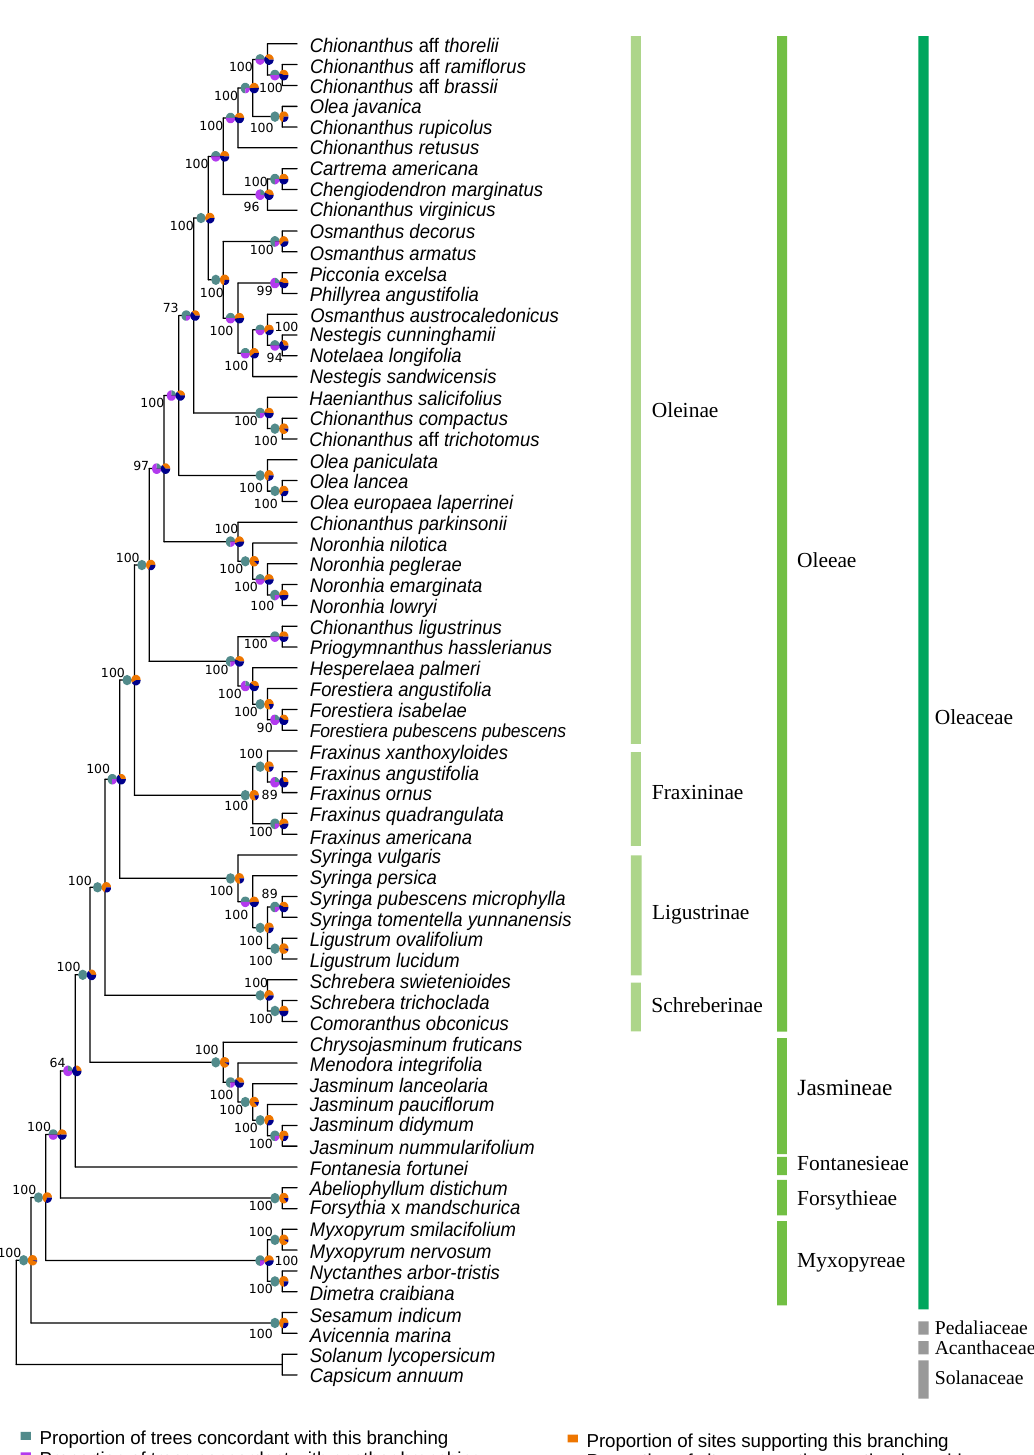
Figure 6. Maximum likelihood topology of Oleaceae family estimated from the partitioned concatenation of 80 plastid coding sequence, 37 mitochondrial genes, the complete nuclear ribosomal DNA cluster and three nuclear genes encoding phytochromes ( phyE-1, phyB-1a, phyB-1b ). Concordance factors were calculated in relation to the species trees inferred for each partitioned dataset. Gene concordance factors are represented by the green/purple pie charts (left), site concordance factors by the blue/orange ones (right). UFB support values are indicated near their respective